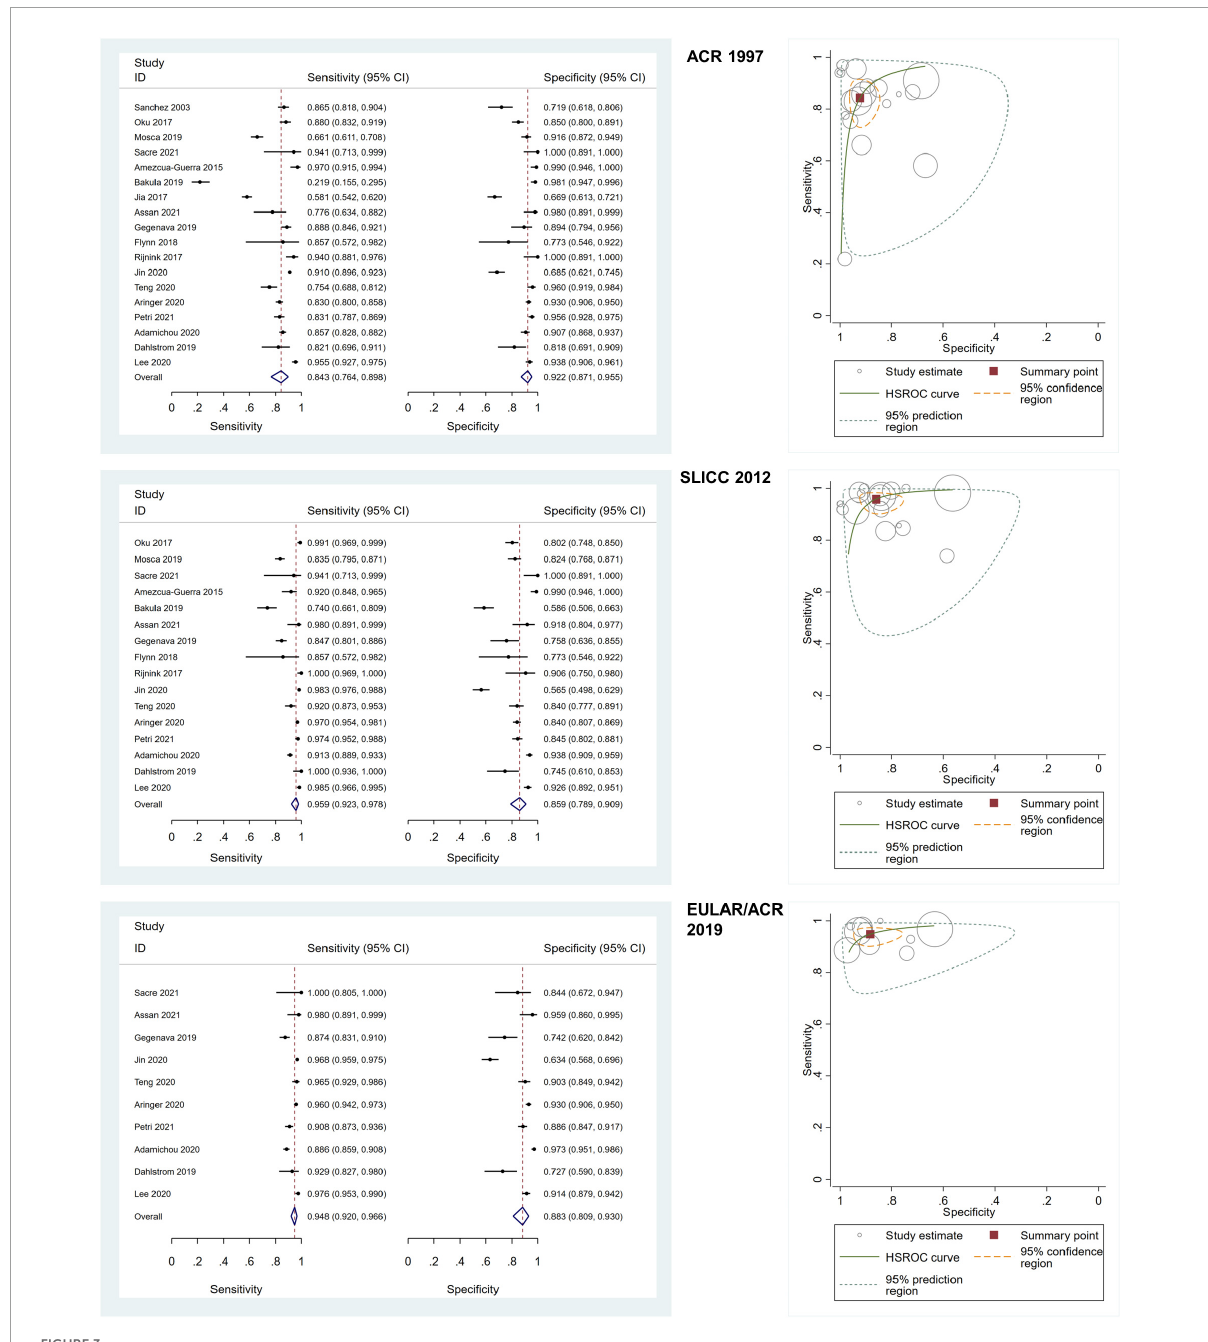
FIGURE3 The forest plots depict the pooled sensitivity and specificity for the included adult-onset SLE studies and hierarchical summary receiver operating curve of the sensitivity and specificity for the American College of Rheumatology (ACR) 1997, Systemic Lupus International Collaborating Clinics (SLICC) 2012, and European Alliance of Associations for Rheumatology (EULAR)/ACR